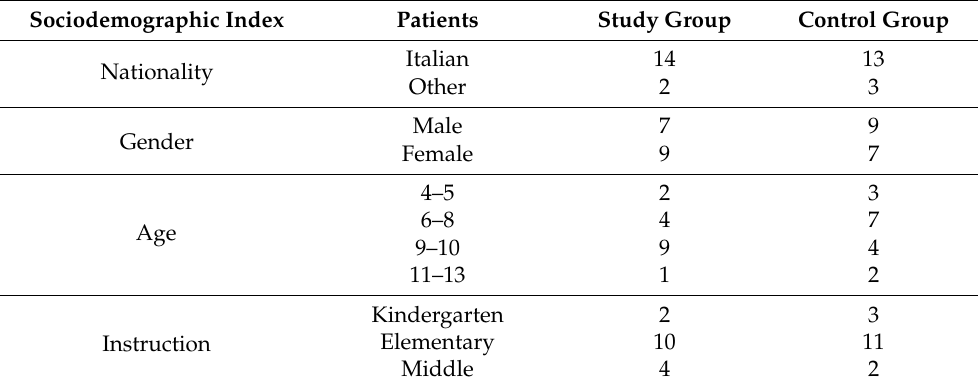
Table 2. Sociodemographic table.